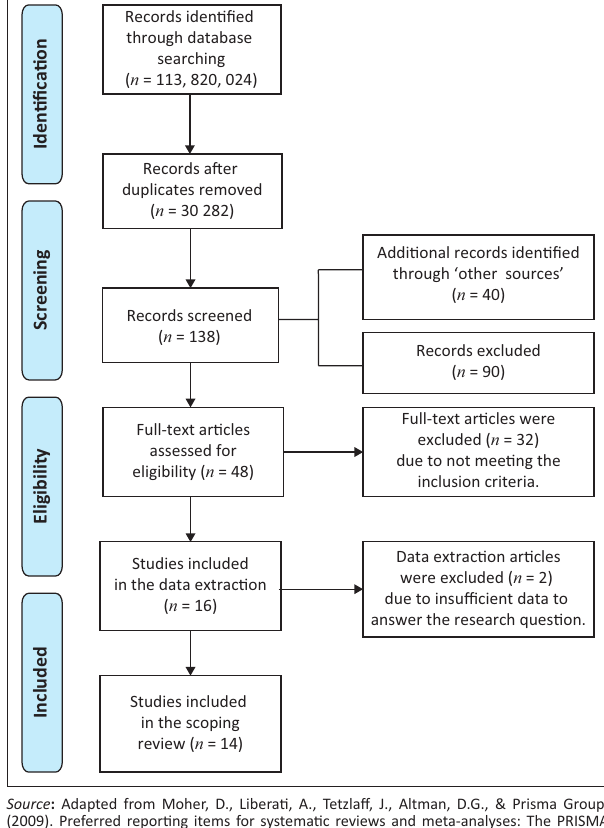
FIGURE 1: PRISMA-ScR flow diagram of